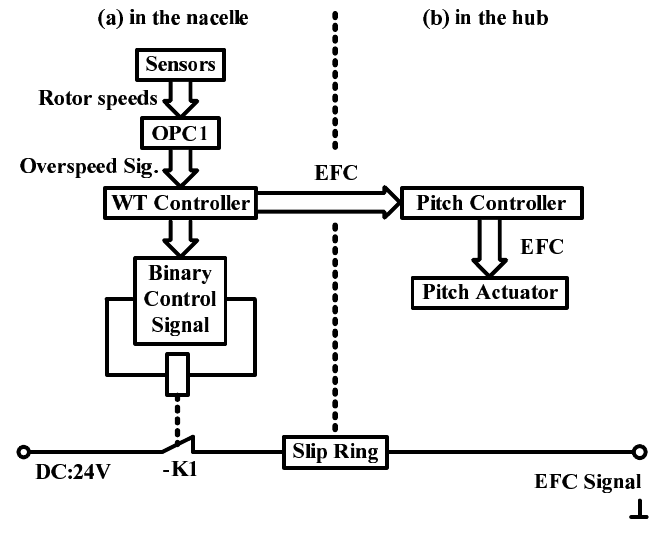
Figure 10. The existing OPC